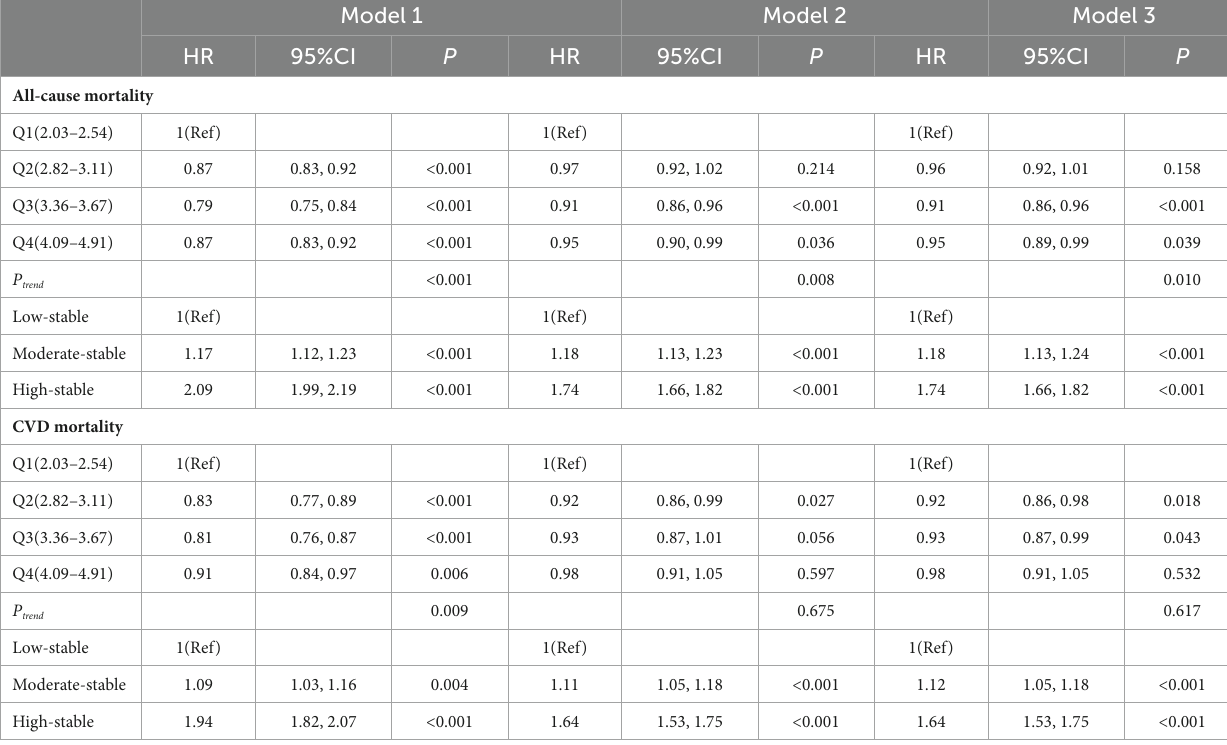
TABLE 2 Cox regression analysis between BRI and all-cause mortality and cardiovascular